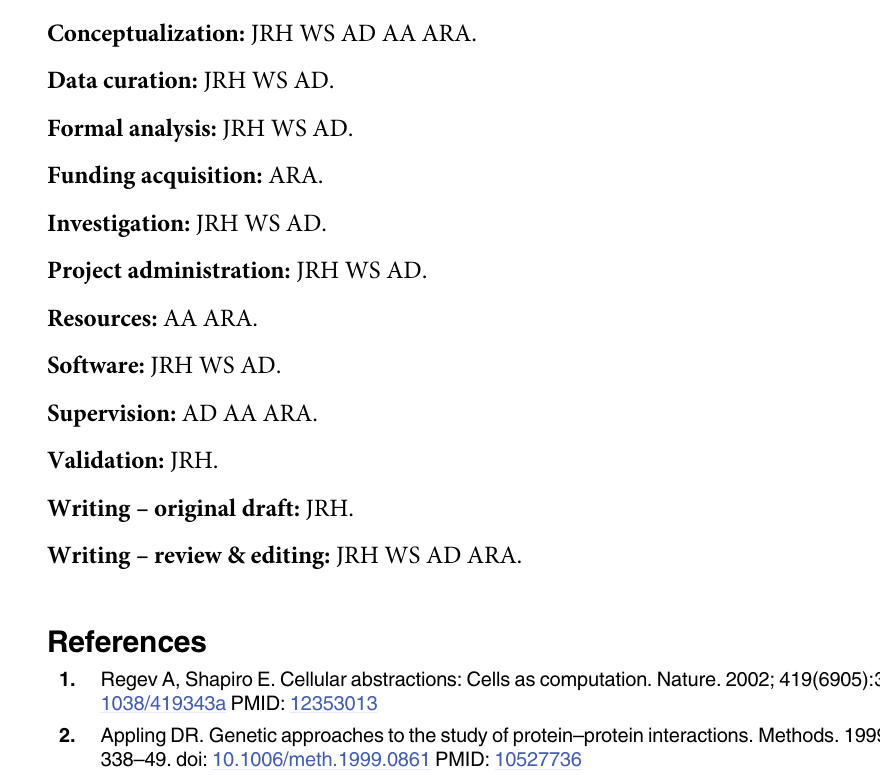
S1 Fig. Microfluidic device for sc-LPCR. The microfluidic droplet maker is a co-flow device consisting of a single outlet 3 inlets, one for oil and one each for cells and PCR mix. Aqueous mixes are flowed into a single channel that intersects a perpendicular channel of oil. Drops are made the junction and their size is function of the device geometry at the junction. This device has a width of 25 microns at the dropmaking junction and a height of 25um, which produces drops of approximately 30 microns in diameter. S2 Fig. Growth of strains in auxotrophy experiment. (a) Library of complementation strains grown in EZ-Rich media for 16 generation. Each time the culture reaches O.D. ~0.32 (4 gener- ations) it diluted back to O.D. 0.02. There is an initial lag of culture growth as the strains recover from transformation (Plus 1), but the culture quickly achieves uniform growth rate. (b) Library of complementation strains grown in EX-Min media for 16 generations. For this culture condition the lag phase is very long (Min 1), and each successive culture grows slightly